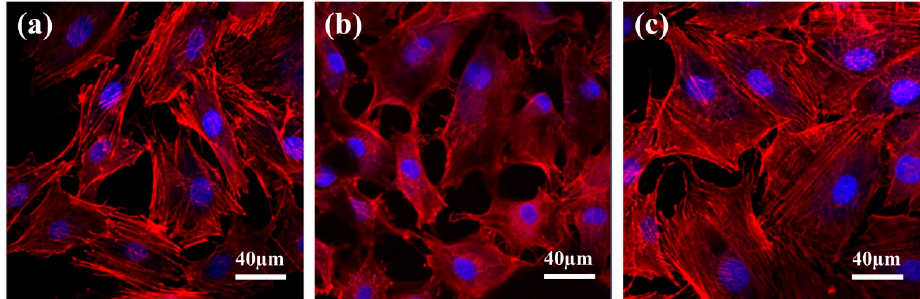
Figure 9. Fluorescent micrographs images of attachment of MC3T3 cells on P-Ti surface ( a ), M-Ti surface ( b ), and MN-Ti surface ( c ). Note: actin, red; nuclei, blue.